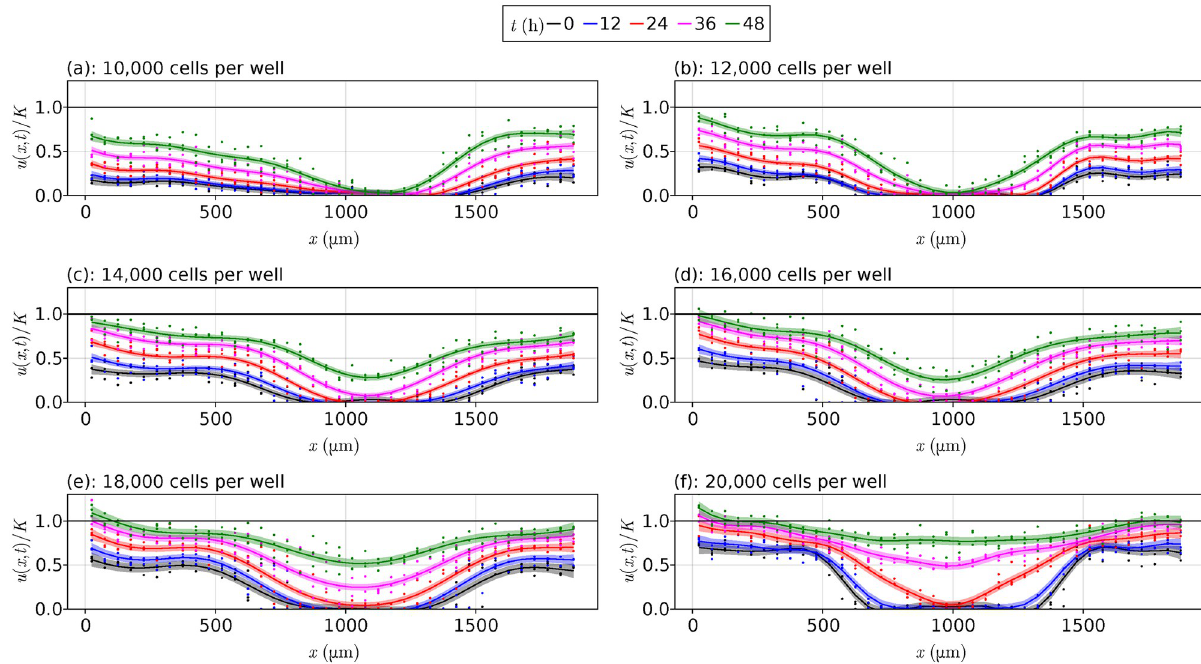
Fig 4. Fitted Gaussian processes. Fitted Gaussian processes to the data from Jin et al. [13] for each initial cell density, with the vertical axis given by u / K rather than u , where K = 1.7 × 10 − 3 cells μ m − 2 . The points are the experimental data, the smooth curves are the fitted Gaussian process curves, and the shaded region represents the uncertainty around these curves implied by the Gaussian process. We estimate the uncertainty in these estimates by shading the interval corresponding to the mean plus or minus the standard deviation. The black horizontal lines are at u / K = 1.